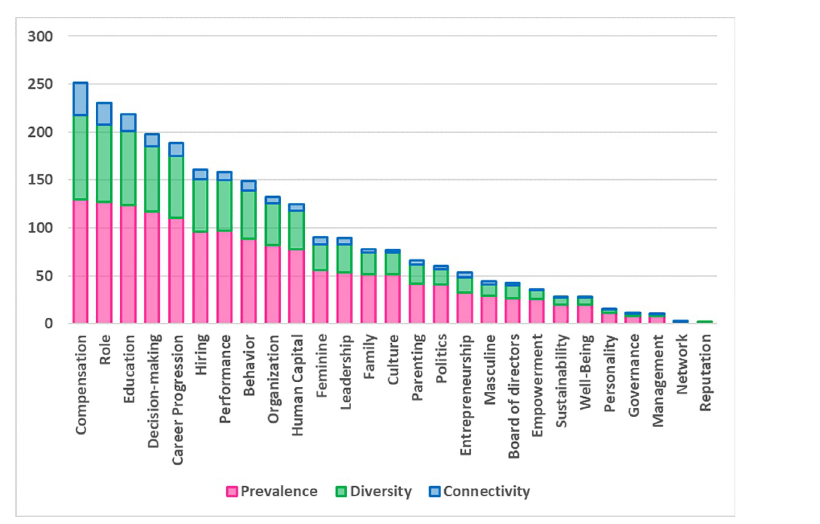
Fig 1. Topic importance (SBS).